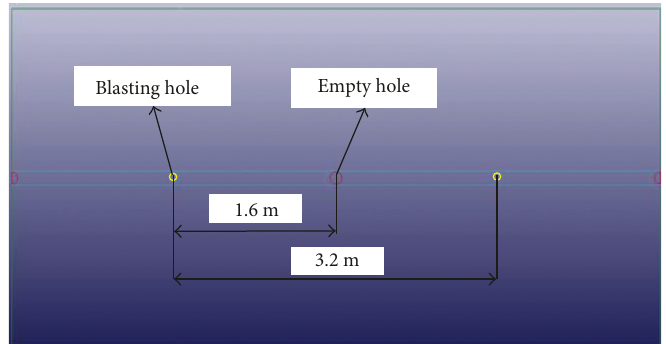
Figure 12: Boreholes layout.